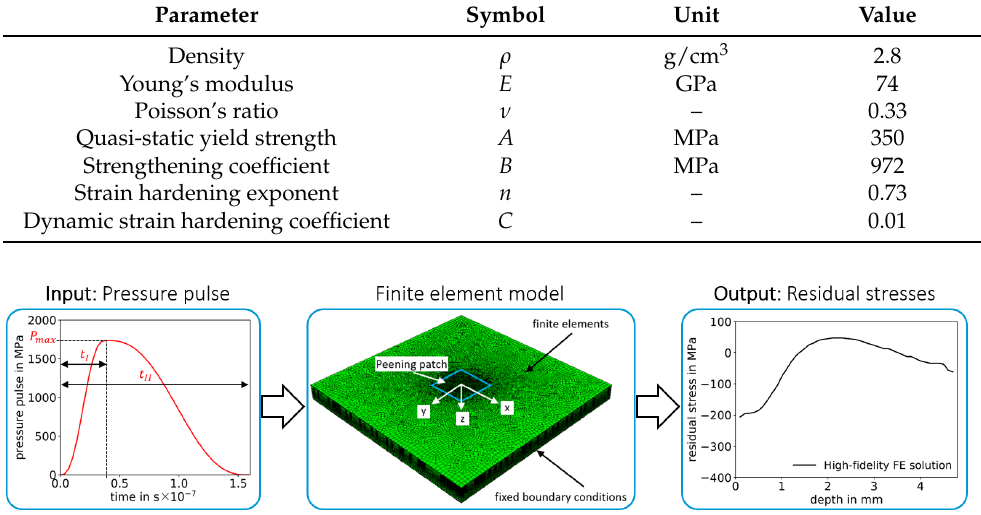
Figure 3. Finite element process model for computing residual stresses induced by pressure pulse from Figure